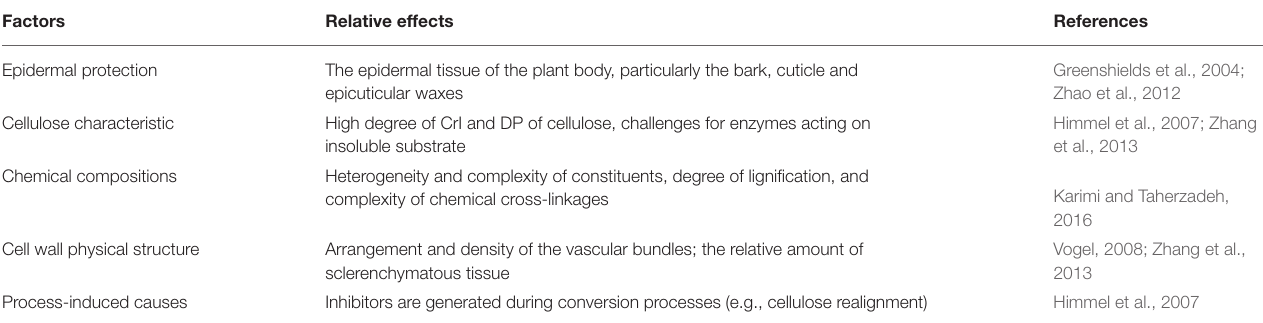
TABLE 3 | Different factors constructing biomass